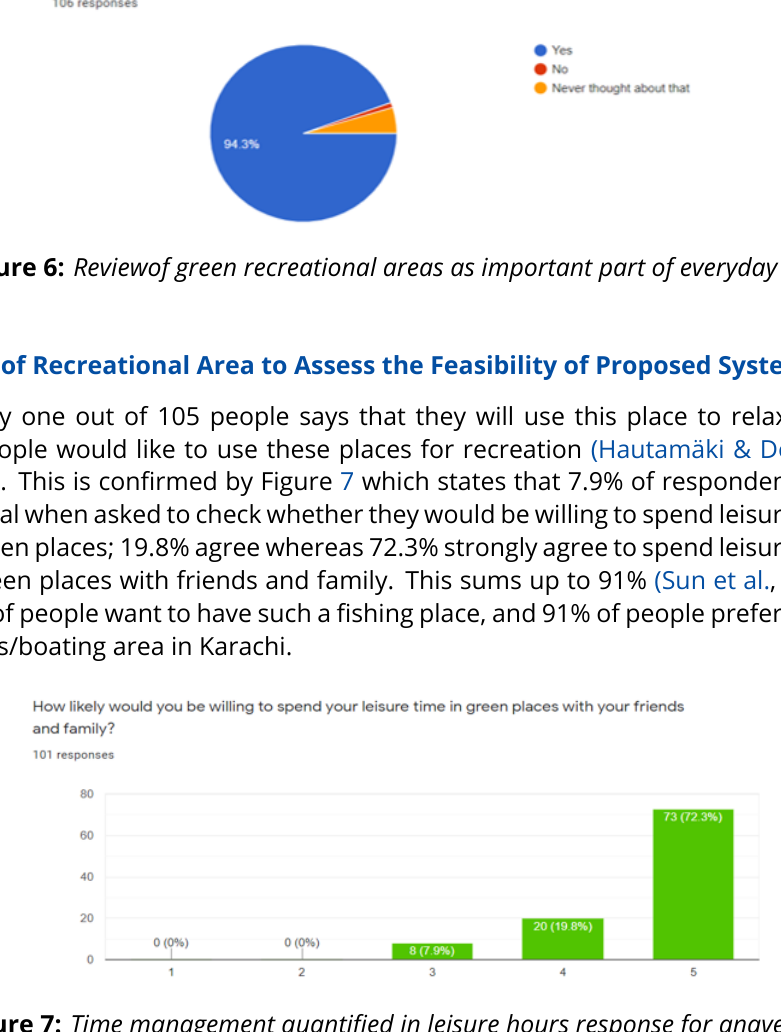
Figure 7: Time management quantified in leisure hours response for anaverage Karachi